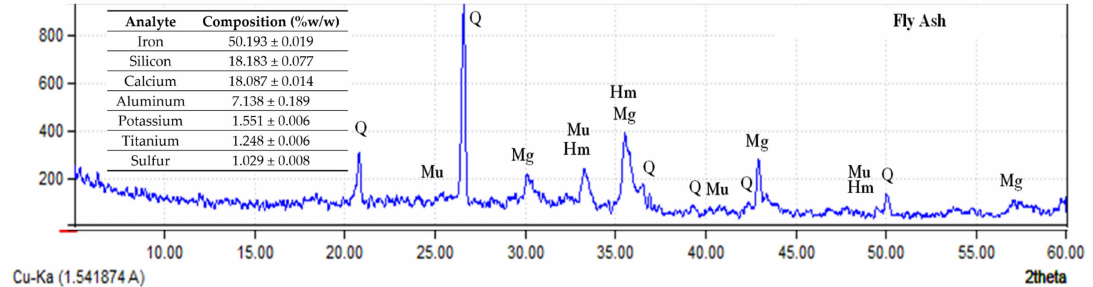
Figure 1. Elemental and mineral composition of the coal fly